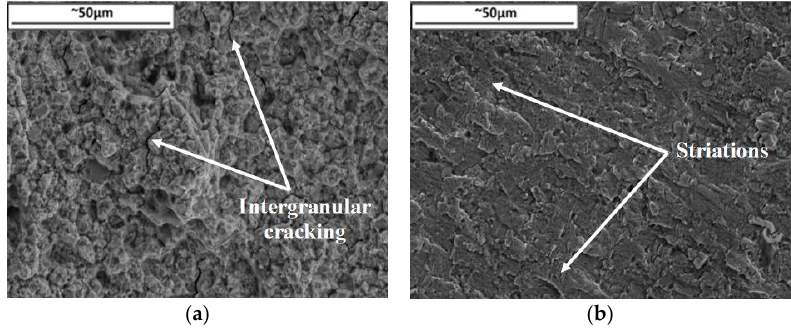
√ m for ( a ) 700 ◦ C and ( b ) 300 ◦